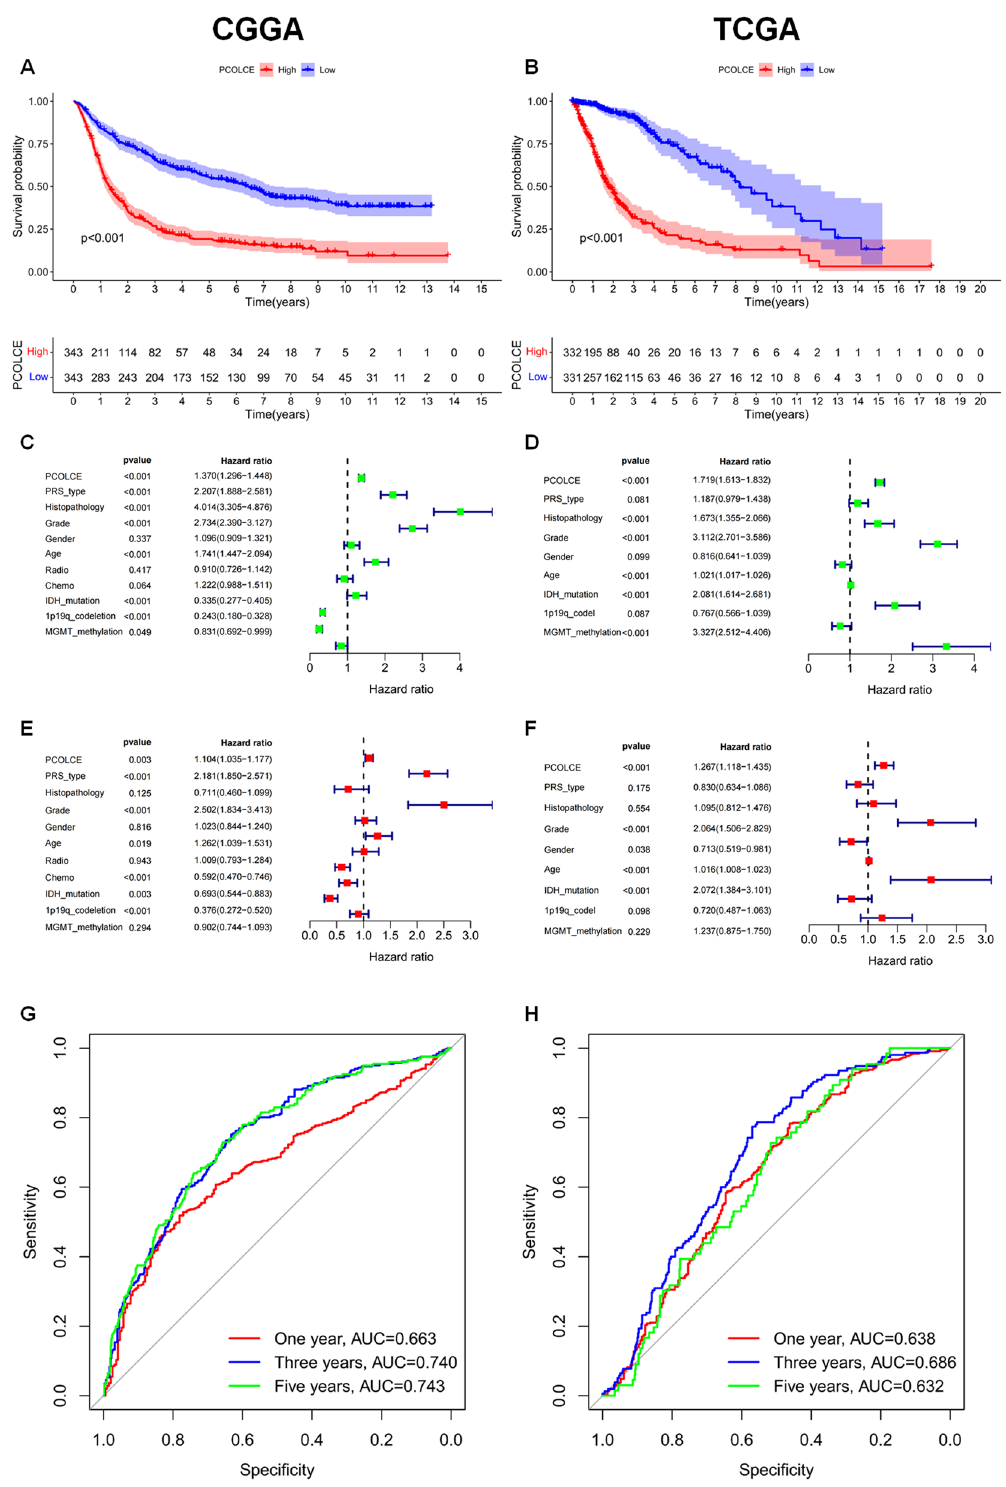
Figure 3. Survival analysis of PCOLCE in CGGA and TCGA patients. ( A , B ) Kaplan–Meier survival curves in the high and low PCOLCE expression groups. ( C , D ) Univariate Cox analysis of PCOLCE expression. ( E , F ) Multivariate Cox analysis of PCOLCE expression. ( G , H ) ROC analysis of PCOLCE for 1-, 3-, and 5-year